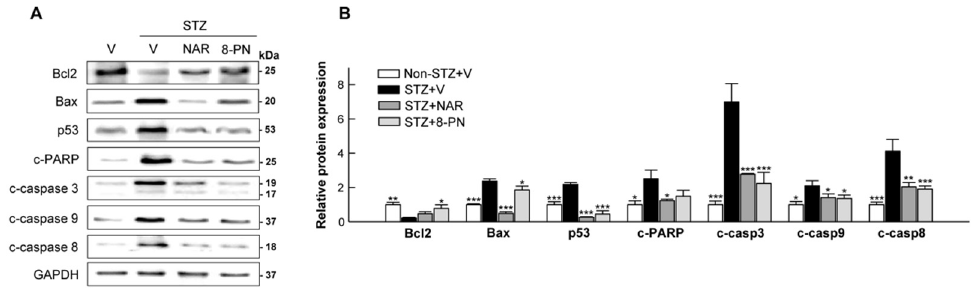
Figure 3. Inhibitory effects of naringenin and 8-PN on apoptotic signaling in the pancreas. ( A ) Representative Western blot images of pancreatic Bcl2, Bax, p53, cleaved PARP, cleaved caspase-3, cleaved caspase-9, and cleaved caspase-8 and ( B ) corresponding quantitative data were used for evaluating β -cell apoptosis. V, vehicle; NAR, naringenin; 8-PN, 8-prenylnaringenin. Data are shown as means ± SEM (n = 6). * p < 0.05, ** p < 0.01, *** p < 0.001 vs. STZ-vehicle group.